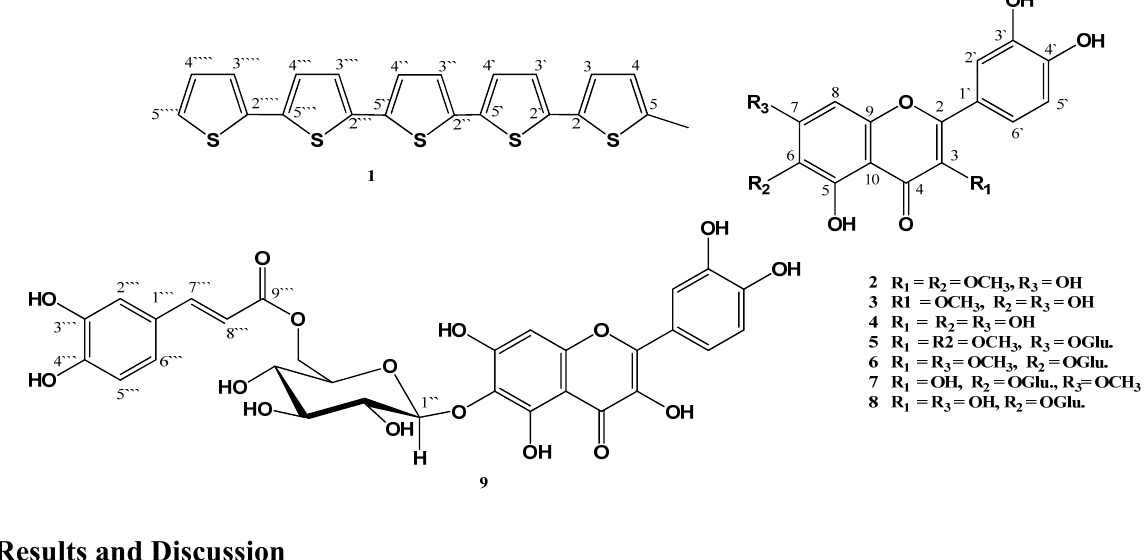
Figure 1. Chemical structures of the isolated compounds 1 – 9